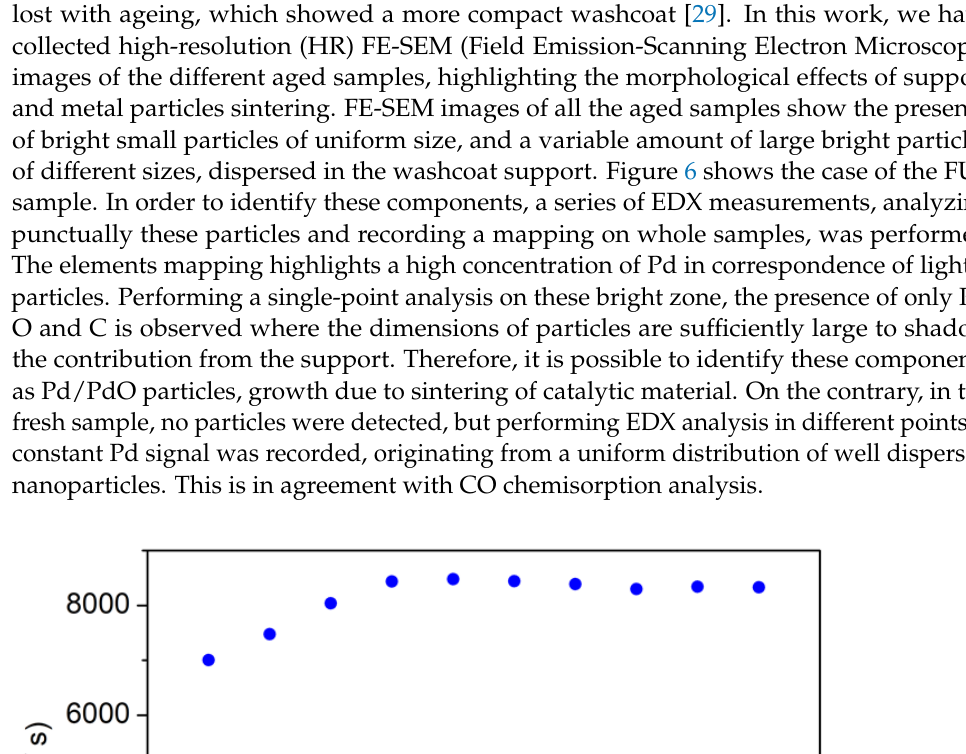
Figure 4. Fresh catalyst sample: ( a ) TCD signal (mV) registered during successive sending of pulse of 800 µL of 10% CO in He carrier until saturation ( b ) Value of integral of the peaks registered.